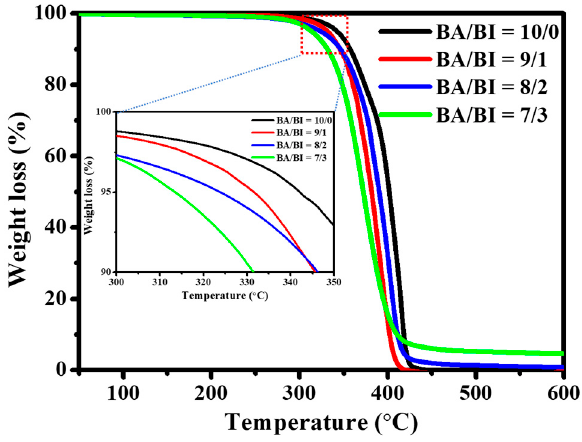
Figure 4. TGA curves of PBABI copolyesters.